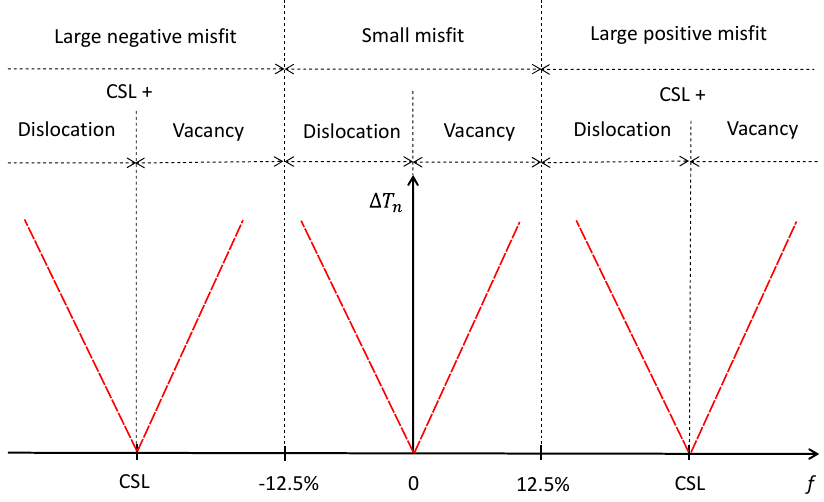
Figure 10. Nucleation undercooling ( Δ T n ) obtained by MD simulations as a function of lattice misfit ( f ) [49]. The data points for the Pb( l )/Cu( s ) system (as labelled) are from this work, and those for the Pb( l )/Al( s ) system (as labelled) are from Ref. [48] and the rest of data points are from Refs. [35,36].